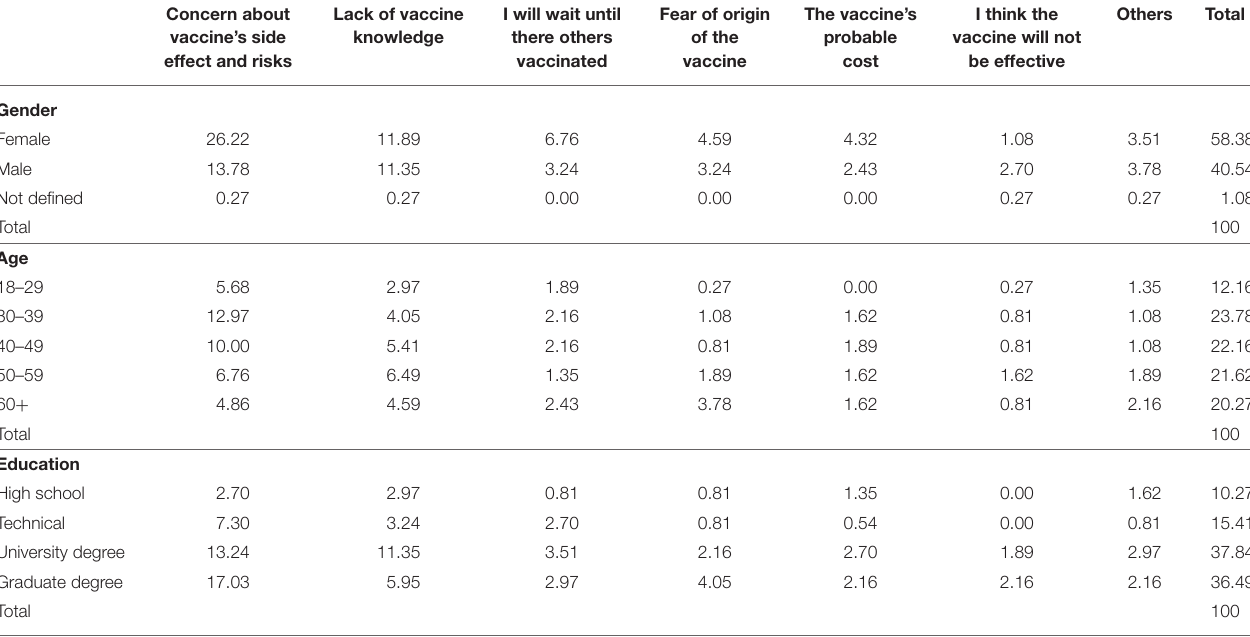
TABLE 2 | Reasons why respondents may avoid vaccination by gender, age, and education (percentage of